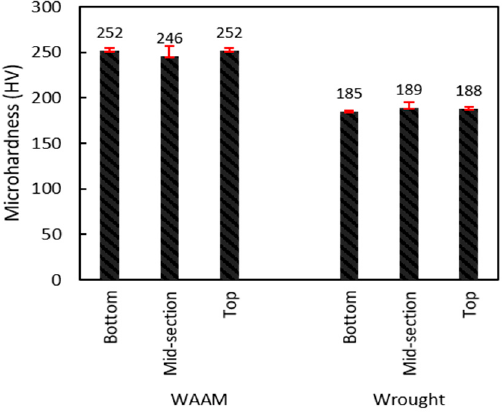
Figure 7. Microhardness test results of the samples.